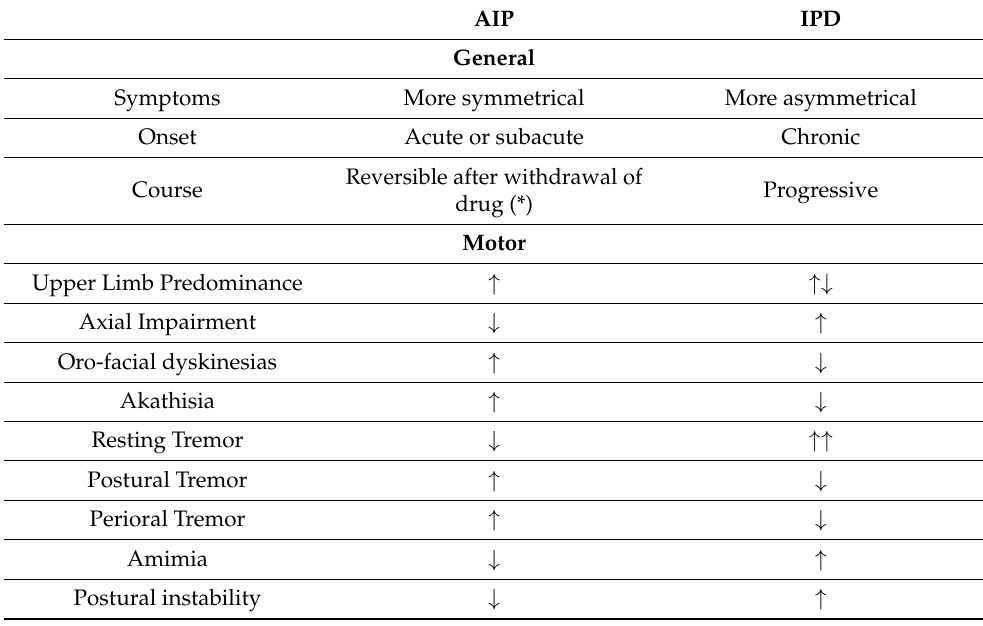
Table 5. Comparison of DIP vs. IPD symptomatology and investigation